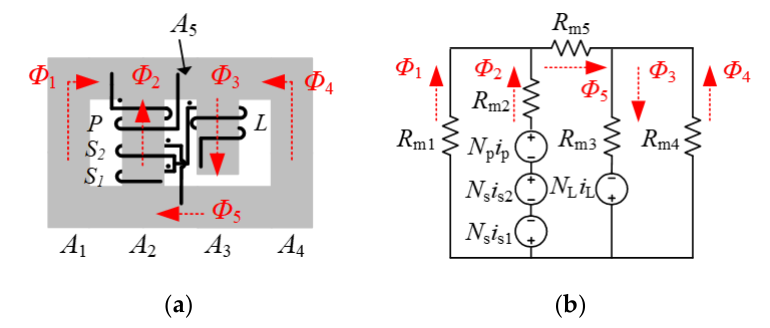
Figure 4. Integrated magnetic component: ( a ) Schematic and ( b ) Equivalent reluctance model.